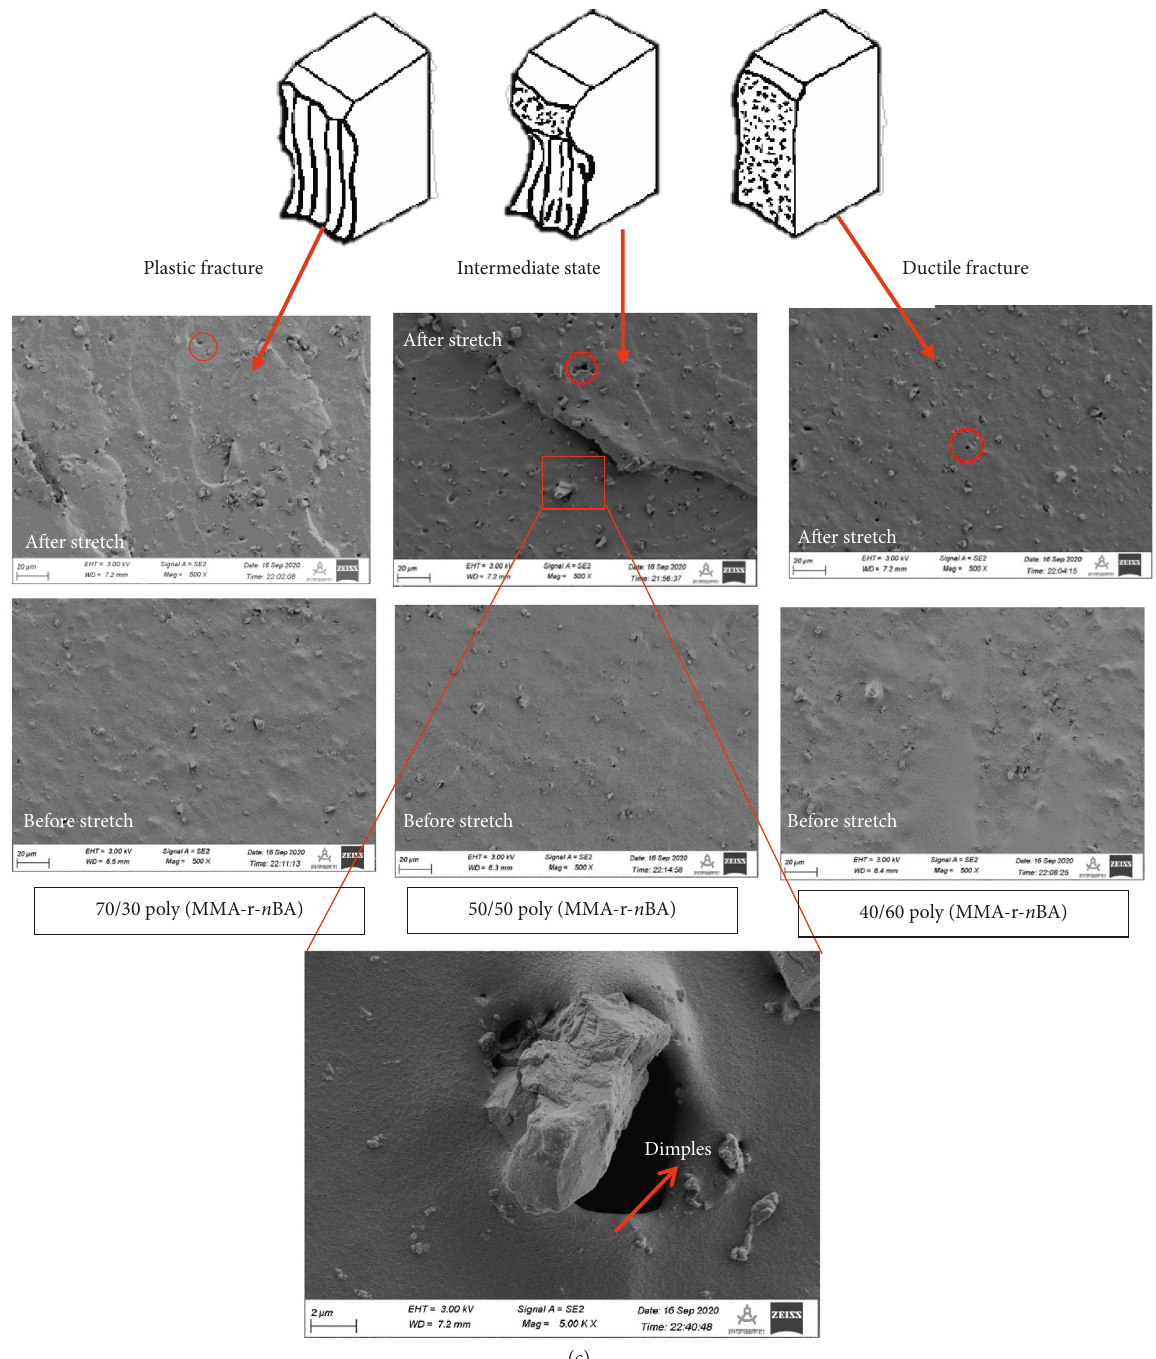
Figure 8: (a) SEM test samples and the diagram of the test area. (b) A comparison of the micromorphology between the poly(MMA-r-nBA) with different molar ratios before and after the samples are stretched. Here, samples are chosen from the fracture surface. (c) Cross-sectional SEM image of the poly(MMA-r-nBA) with different molar ratios before and after the samples are stretched; and a magnified view of the dimple region is